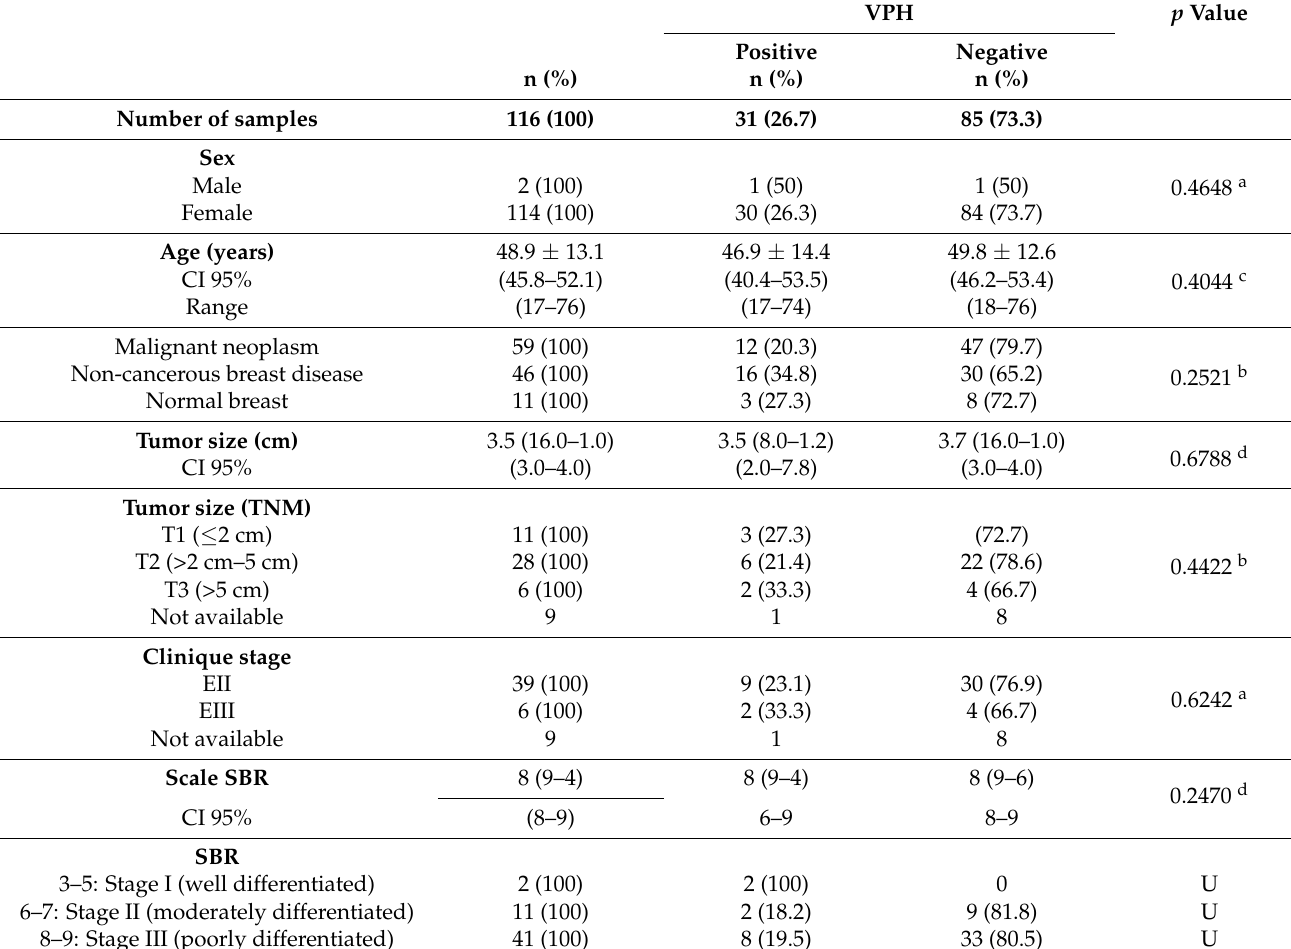
Table 4. Relationship between HPV and clinicopathological parameters of breast